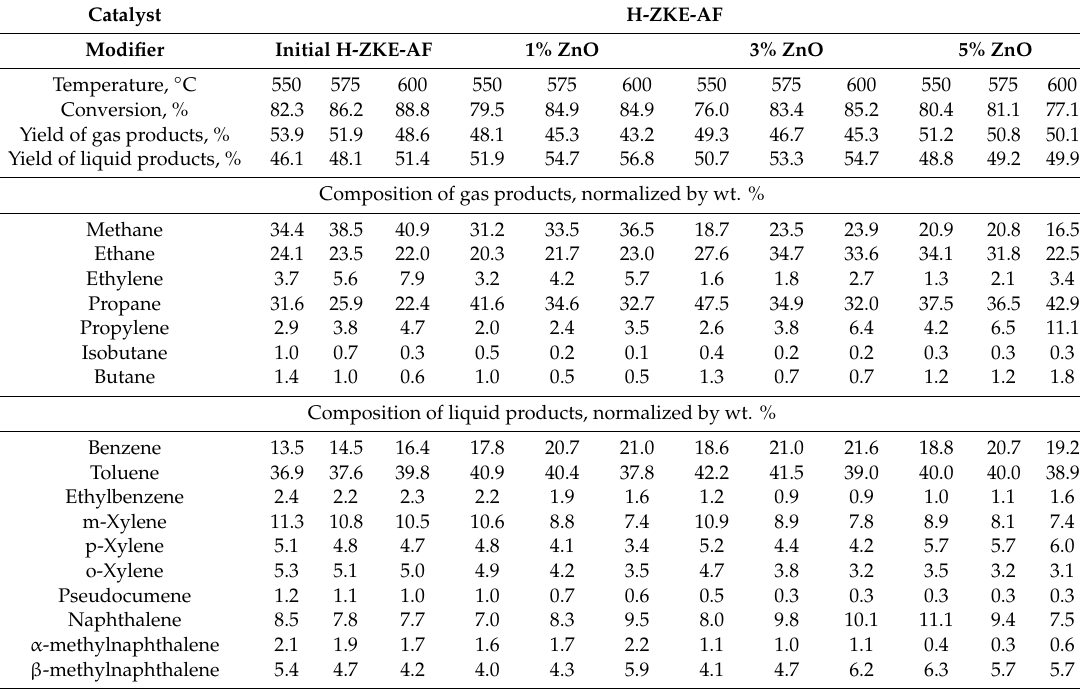
Table 1. E ff ect of temperature on composition of products (wt. %) of propane–butane fraction